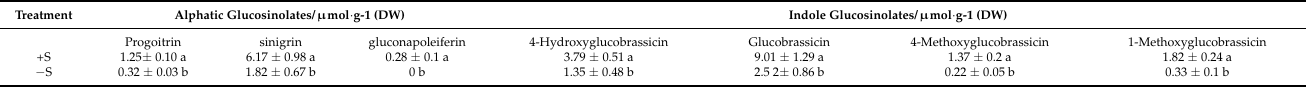
Table 1. Effect of sulfur supply on the composition and content of glucosinolates.